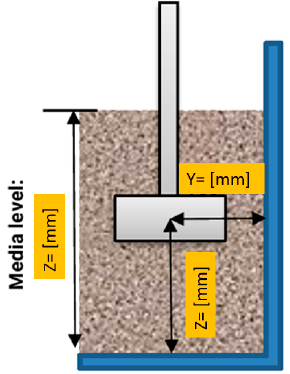
Figure 4. Workpiece location in the drum [17].